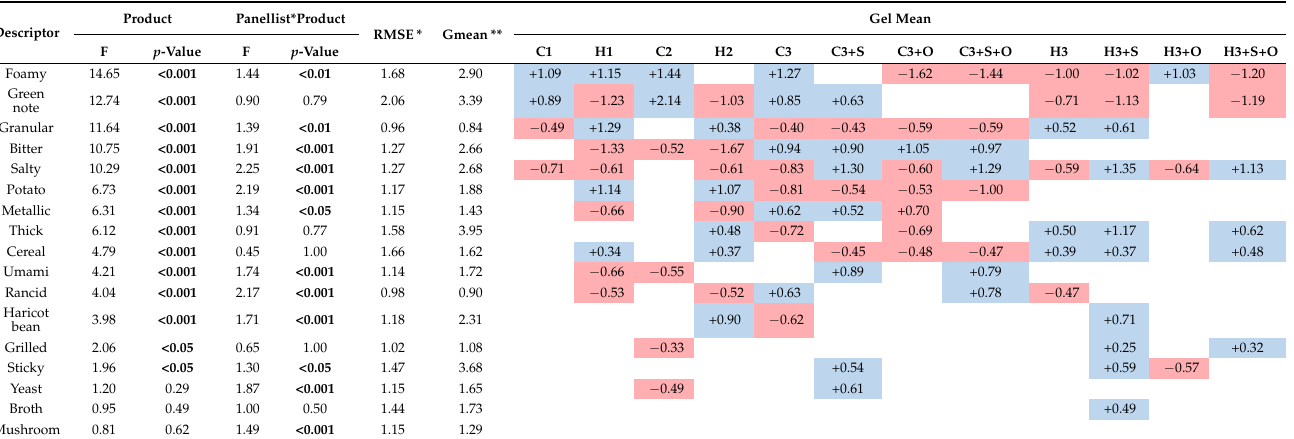
Table 4. Results of ANOVA (product + panellist + panellist*product) to examine panellist performance (significant p -values are in bold ( α = 0.05)) and comparison of the gel mean with the Grand mean